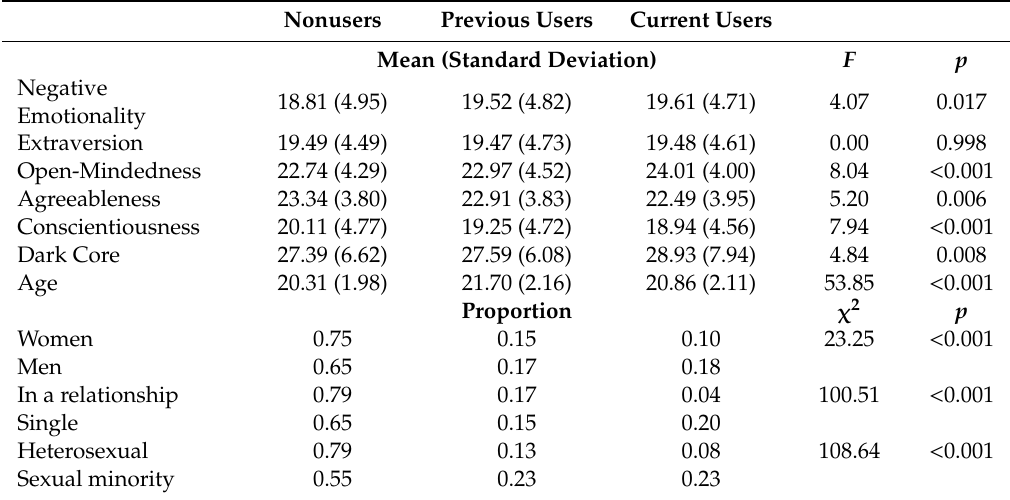
Table 2. Means and standard deviations (for numerical variables), proportions (for categorical variables), and significance testing according to dating app